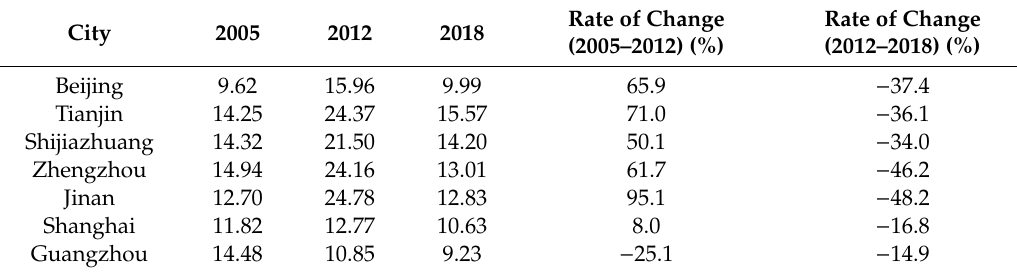
Table 2. The change in tropospheric NO 2 columns over some leading cities in high concentration regions during 2005–2018. (unit: 10 15 molec cm − 2 ).